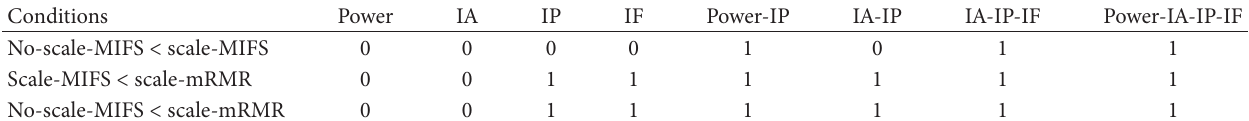
Table 3: The 𝑡 -test comparison between different feature processing methods using SVMs (the confidence level is 0.01).